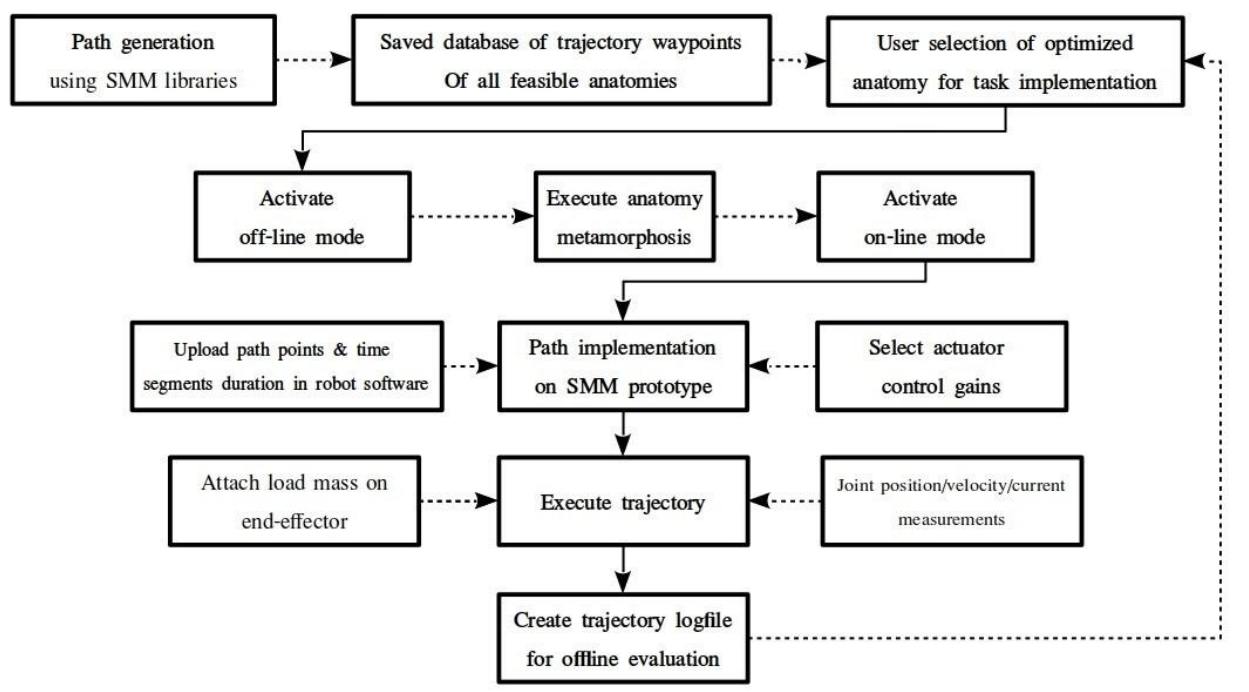
Figure 6. Task implementation on SMM prototype for a user specified optimized anatomy.